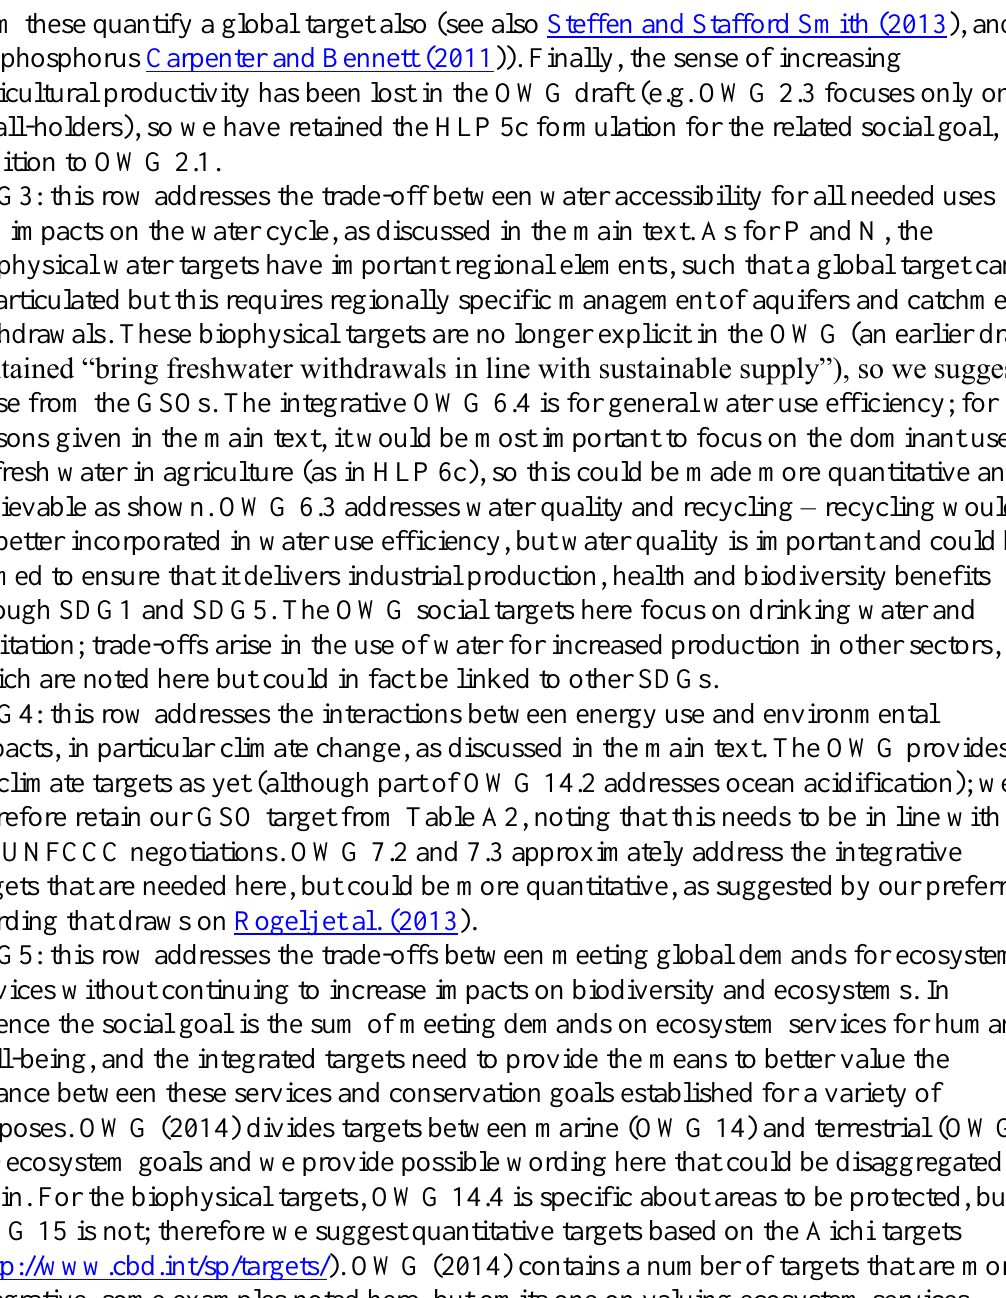
Table A3: Goals with examples of possible biophysical, socio-economic and integrated targets, drawing on the OWG (2014) report where possible (see